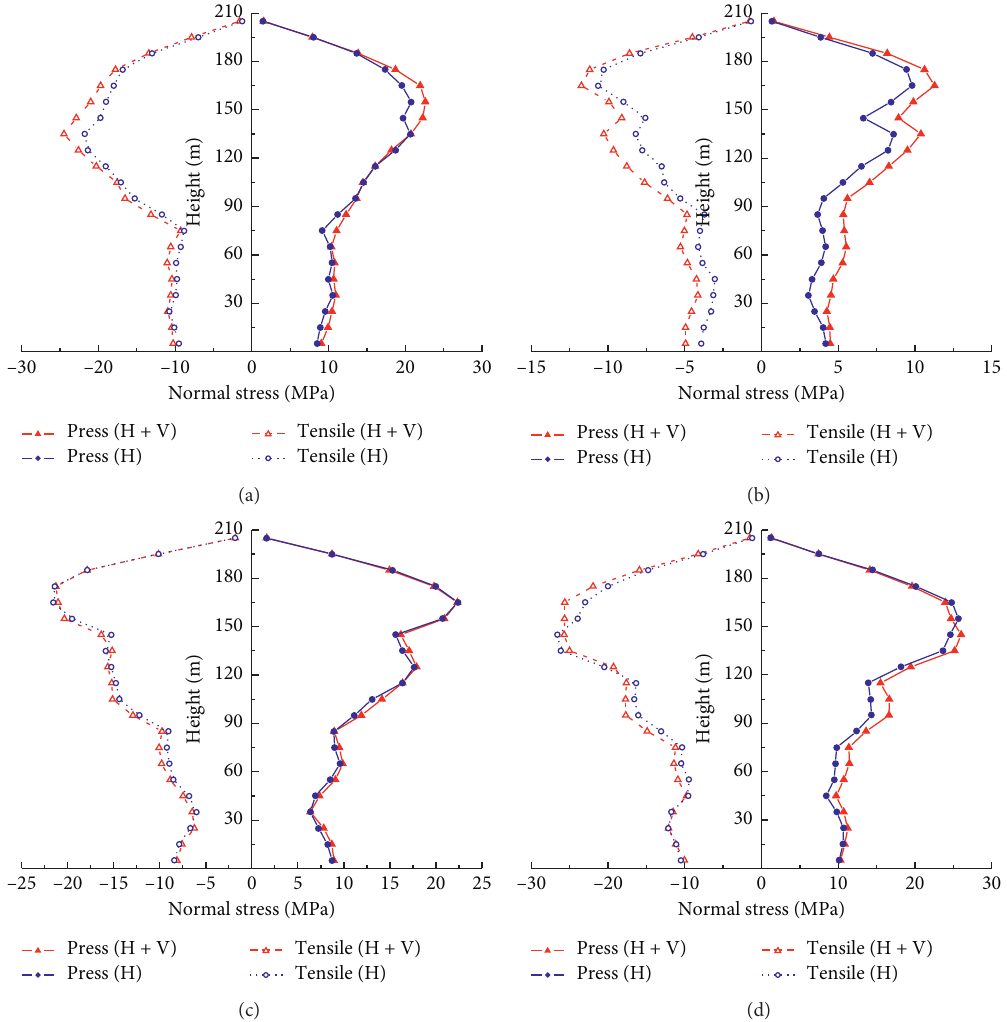
Figure 12: Spatial distributions of maximum earthquake normal stresses at different cross sections for the 210m high chimney under two types of seismic load applied for each of the four earthquake wave actions: (a) Landers wave (No. 1); (b) Loma Prieta wave (No. 2); (c) Borrego wave (No. 3); (d) Chichi wave (No.